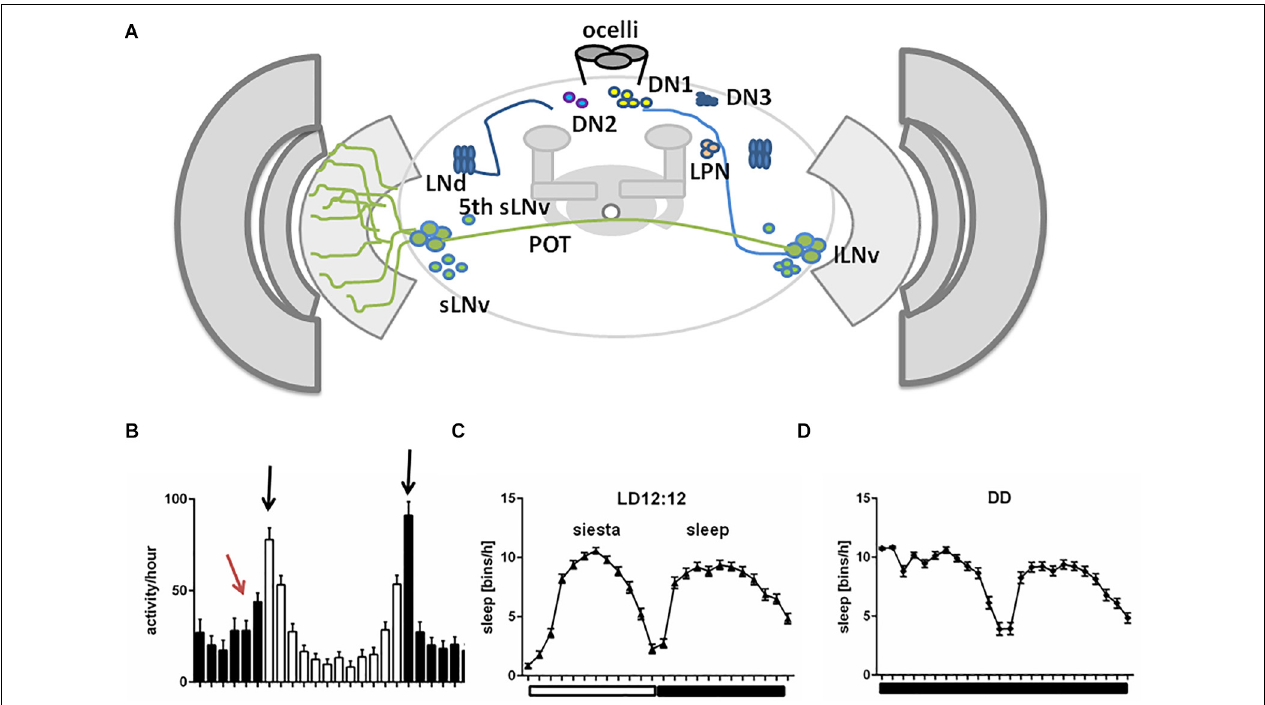
FIGURE 1 | A schematized representation of clock network in Drosophila brain. (A) The main pacemaker cells, lateral ventral neurons, small (s-LNvs) and large (l-LNvs) are located in accessory medulla. l-LNvs send projections, called posterior optic tract (POT), to the contralateral hemisphere and form network of processes in the medulla neuropil, while s-LNvs innervate dorsal brain. Six lateral dorsal neurons (LNds) and three lateral posterior neurons (LPNs) are located above the main pacemakers. In the dorsal brain, three groups of dorsal neurons are located (DN1s, DN2s, DN3). (B) Representative activity profile in light:dark (LD12:12) conditions with pointed morning/evening peaks (black arrows) and morning anticipation (red arrow). (C,D) Representative sleep pattern observed in LD cycles (C) , with siesta during the day and sleep during the night and constant darkness (DD) conditions (D)